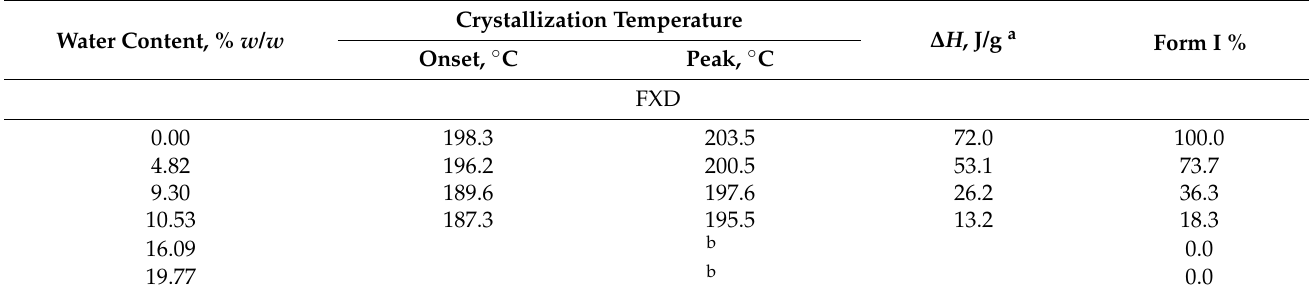
Table 2. Thermal characterization of FXD by wet-granulation process.